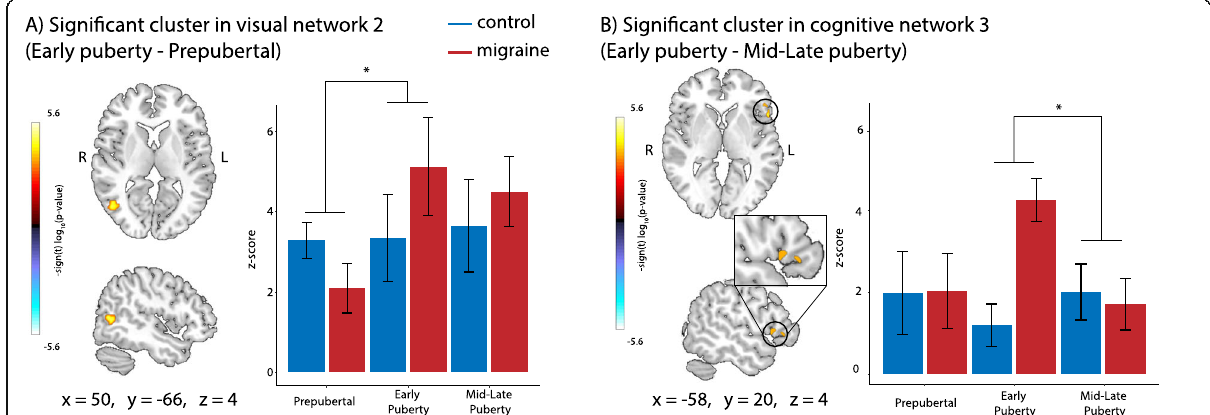
Fig. 4 Group by pubertal status interaction effects on connectivity. a Cluster in the lateral occipital cortex exhibiting significant group by pubertal status interaction effects on connectivity within visual network 2 (number of voxels = 137), and connectivity values per group. b Cluster in the inferior frontal gyrus exhibiting significant group by pubertal status interaction effects on connectivity within cognitive network 3 (number of voxels= 45), and connectivity values per group. * p < 0.05